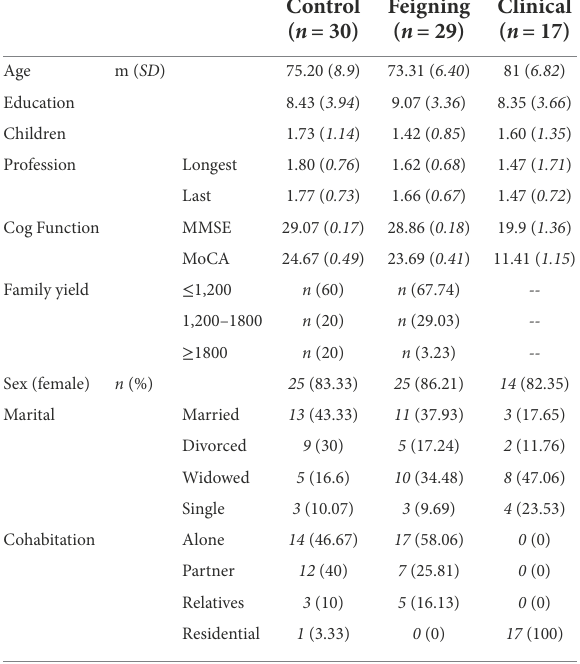
TABLE 1 Sample characteristics for the Control, Feigning, and Clinical